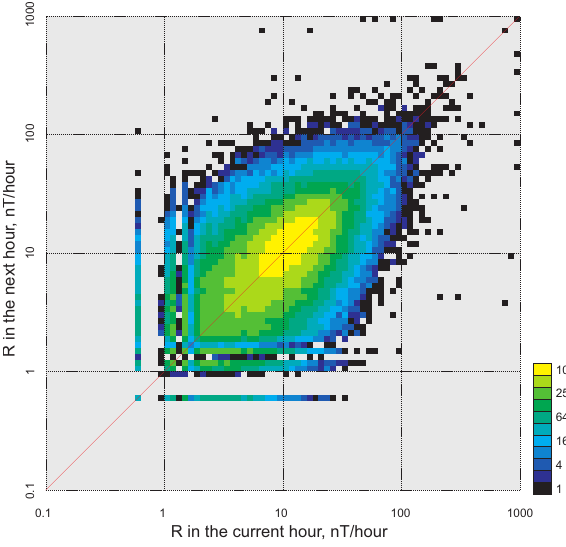
Fig. 5. R for next hour vs R for current hour at CLF (computed from hourly means): 2-D histogram. The color indicates the number of pairs in a cell, see color bar.